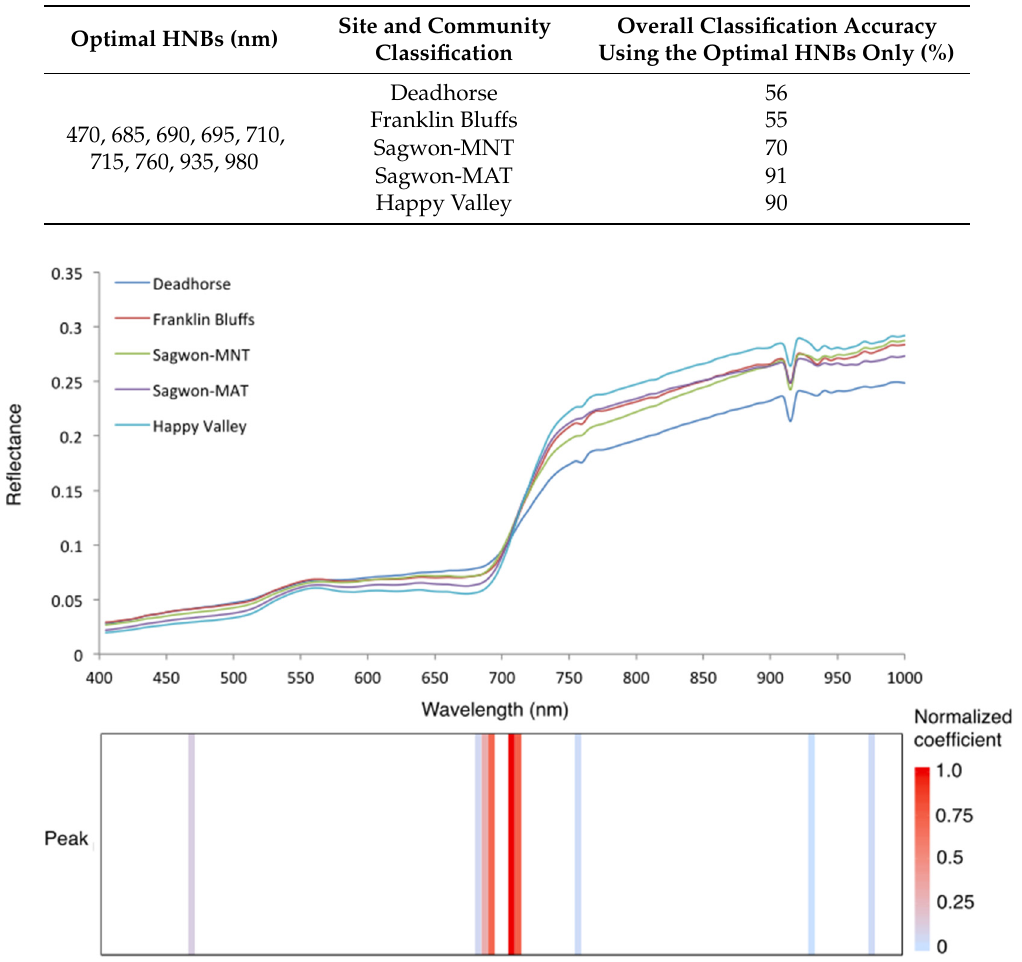
Table 6. Optimal hyperspectral narrowbands (HNBs) for the five Dalton Highway sites and overall classification accuracy of the linear discriminant analysis (LDA) using the top ten percent of optimal HNBs.